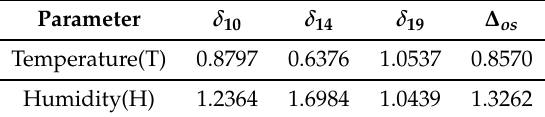
Table 4. Data accuracy of our scheme.